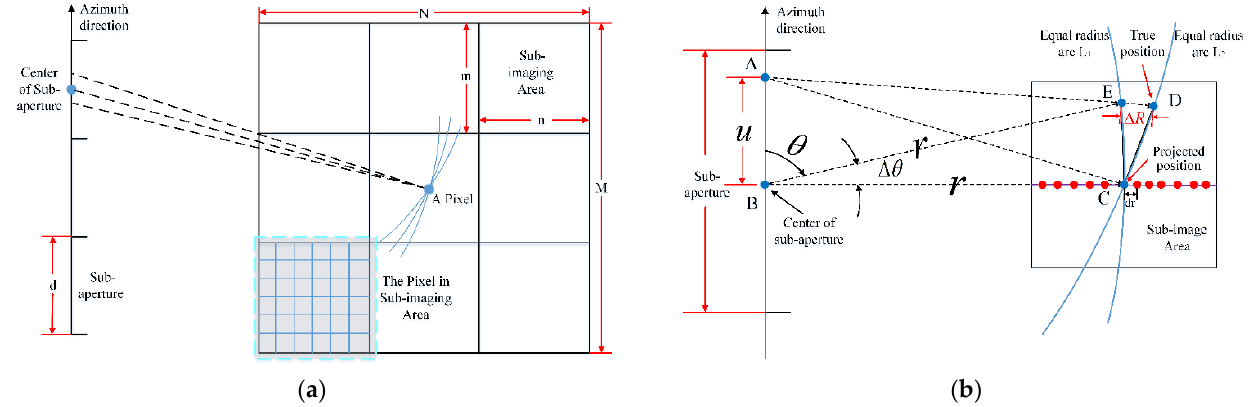
Figure 3. The schematic diagram of FBP in the division of aperture and imaging area ( a ), and in the range error calculation ( b ).